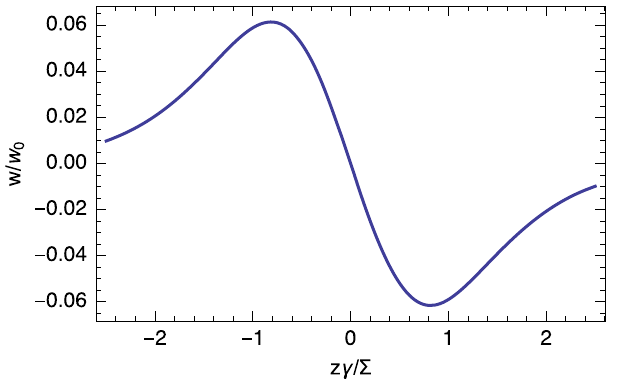
FIG. 4. Dimensionless wake for the hadron-electron interaction in the cooling